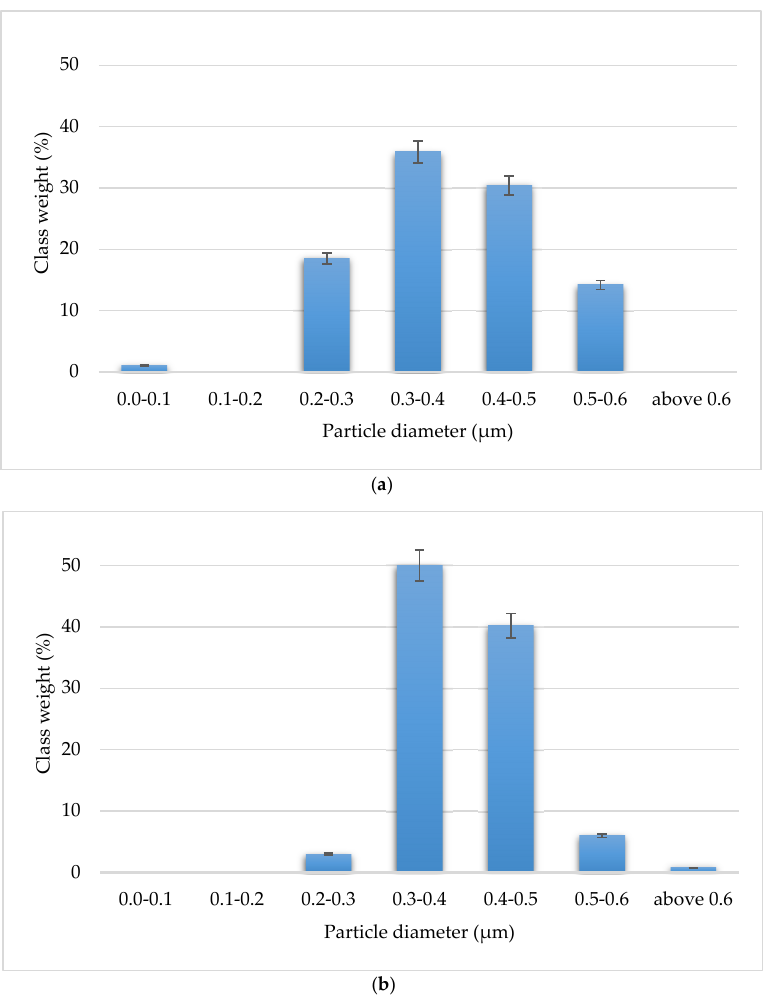
Figure 11. WC grain size distribution: ( a ) in WC-Co/diamond composites, ( b ) in WC starting pow- der.